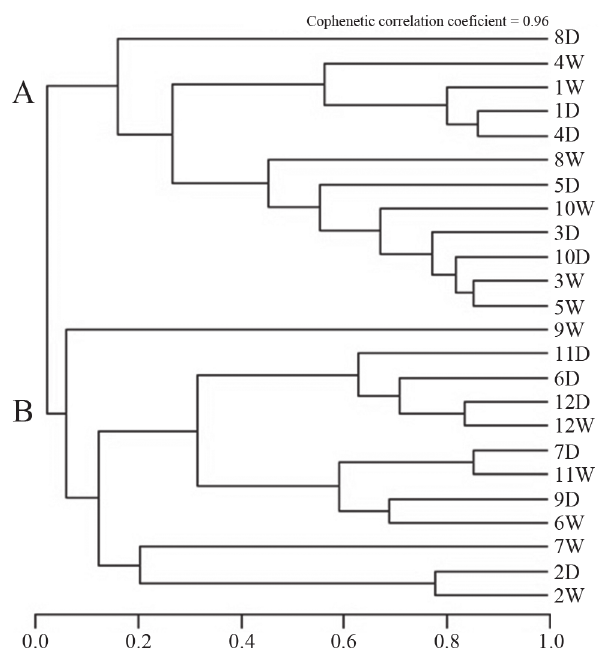
Fig. 3. Similarity dendrogram of stretches based on fish species occurrence from dry (D) and wet (W) seasons in streams of the APA Gama and Cabeça de Veado. Note the two groups that represent farther ( A ) and closer ( B ) of